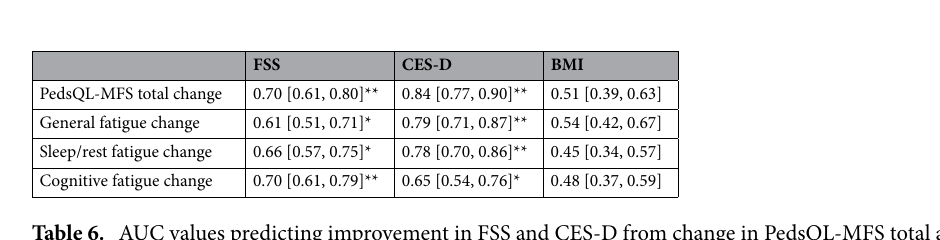
Table 5. Mean differences in PedsQL-MFS scores according to BMI change category where significant BMI change ≥ 5%.